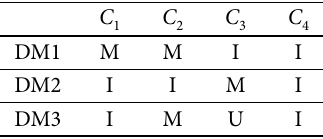
Table 5. individual decision